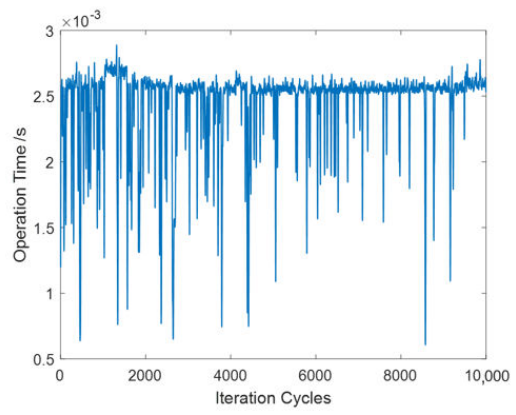
Figure 10. 10,000 iterations of Viaxl elapsed